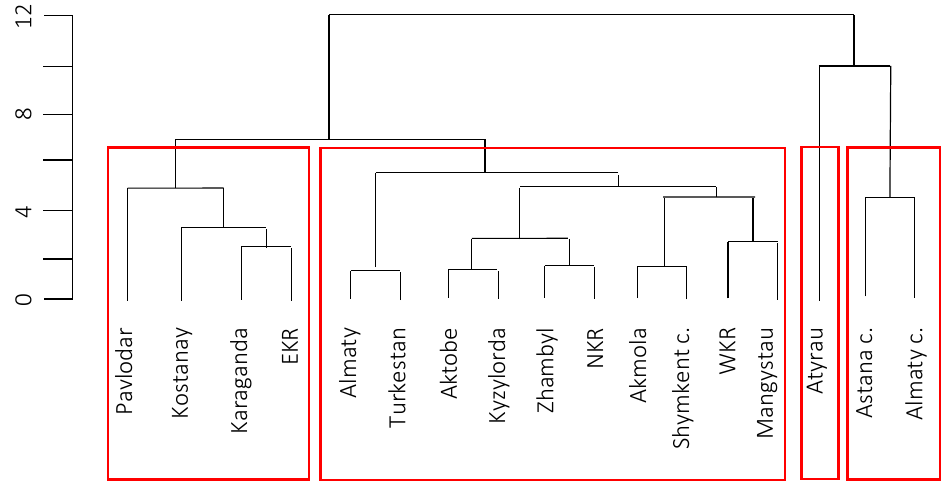
Figure 3. Dendrogram of clusters of regions of Kazakhstan, Ward’s